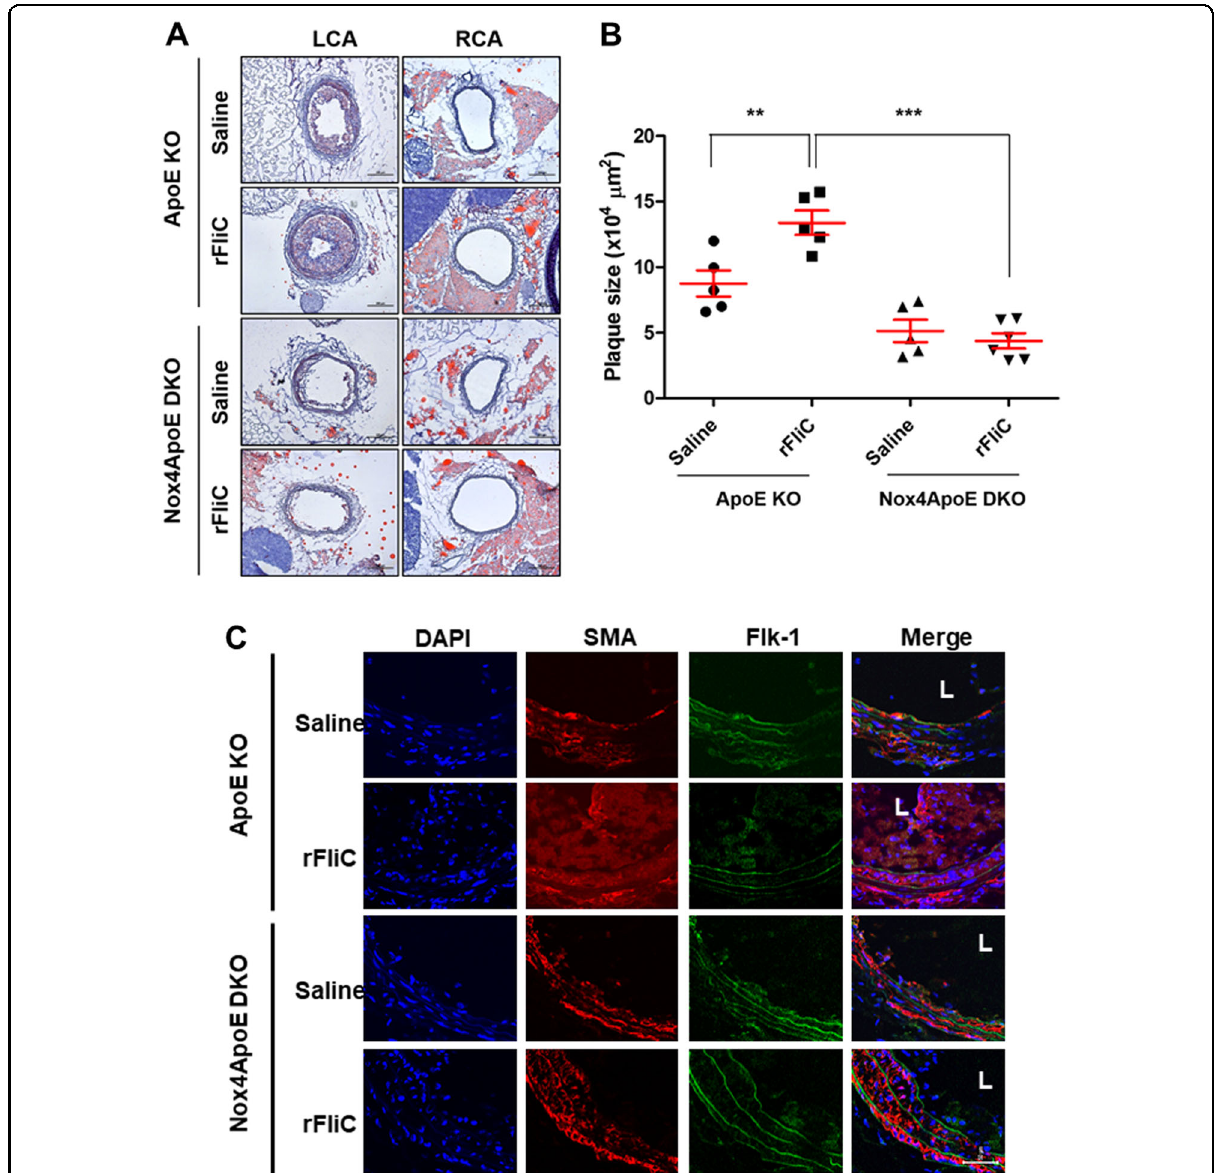
Fig. 6 Nox4 regulates fl agellin-induced plaque formation and SMC migration in a partial carotid artery ligation model. a Oil red O staining of the left carotid artery (LCA) and right carotid artery (RCA) 10 days after partial ligation surgery (1 mm from the ligation site, scale bar = 200 μ m). b Quanti fi cation of plaque sizes using ImageJ ( N = 5, mean ± SEM, ** p < 0.01, *** p < 0.001). c Immuno fl uorescence for SMA (red) and Flk-1 (green). The color-merged images are shown in the right panels. Scale bar = 50 μ